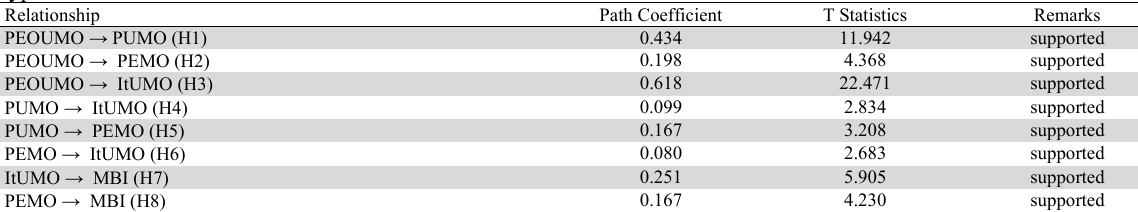
Hypothesis and Path Coefficient